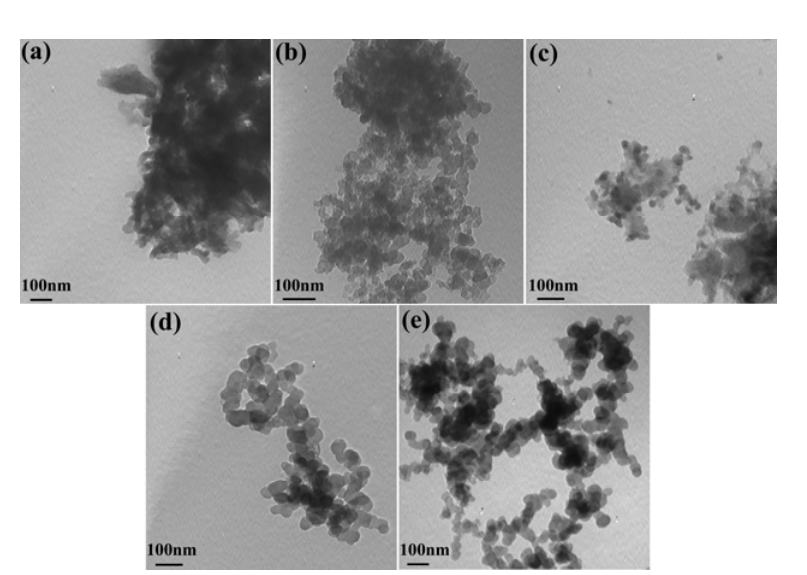
Figure 4. Transmission electron microscopy (TEM) image of PANI with different amounts of water: ( a ) PANI-0; ( b ) PANI-0.25; ( c ) PANI-0.5; ( d ) PANI-0.75; ( e )